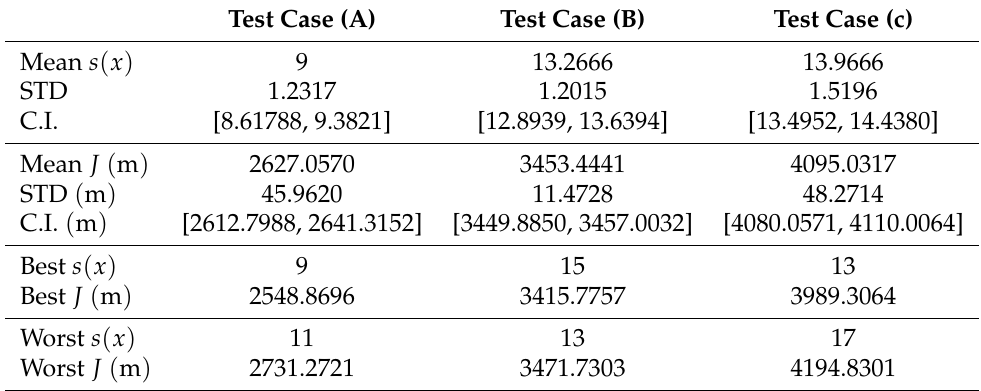
Table 2. Differential Evolution for Variable-Length-Vector (VLV-DE) results for test cases (A), (B) and (C).